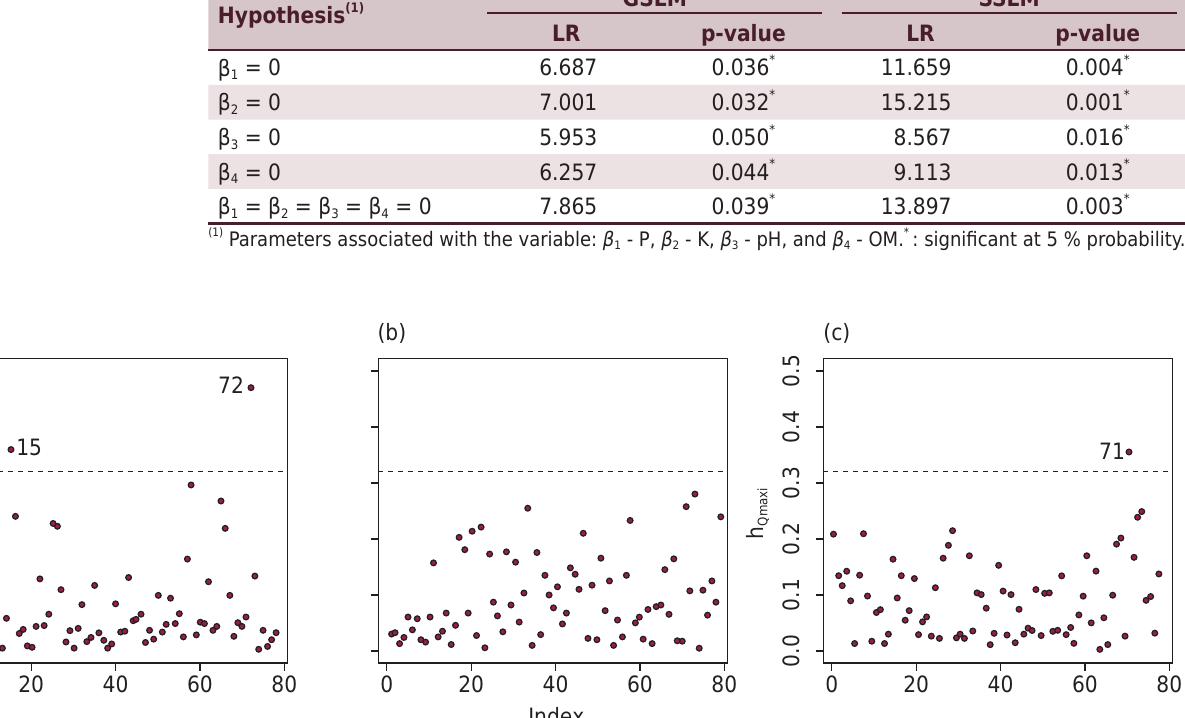
Table 3. Likelihood ratio statistic ( LR ) of the parameter vector β of the Gaussian spatial linear model (GSLM) and slash spatial linear model (SSLM) at 5 % probability Hypothesis (1)